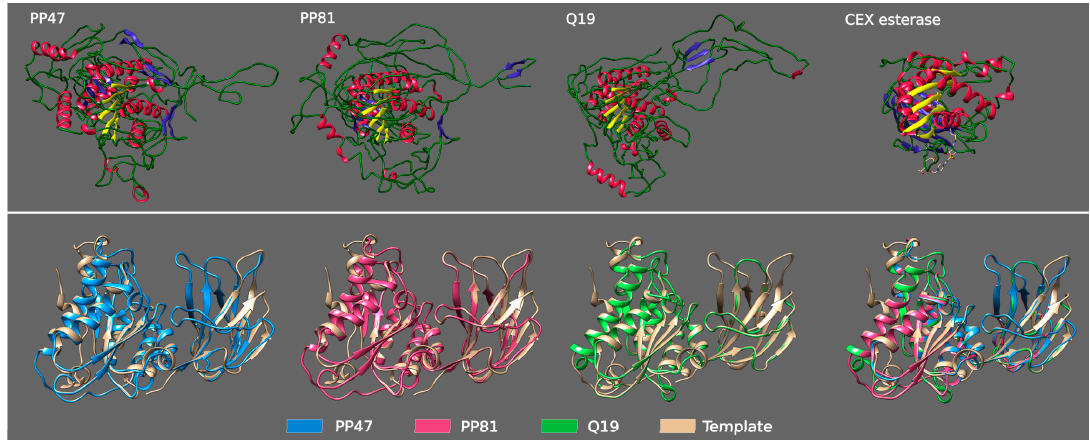
Figure 9. Upper picture: 3D homology modelling of tail spike proteins of Pectobacterium phages Q19, PP47 and PP81, and PDB structure of SGNH domain of bacterial esterase (CEX) active on acetylated mannans PDB structure 6hfz. Lower picture: 3D-alignment of modelled Q19, PP47 and PP81 tail spike SGNH domains, with SGNH domain of bacterial esterase (CEX) as a template. In the upper picture, the five parallel β -sheets intrinsic for all SGNH are colored yellow; the other β -sheets are colored blue, α -helices are colored red and coils are colored